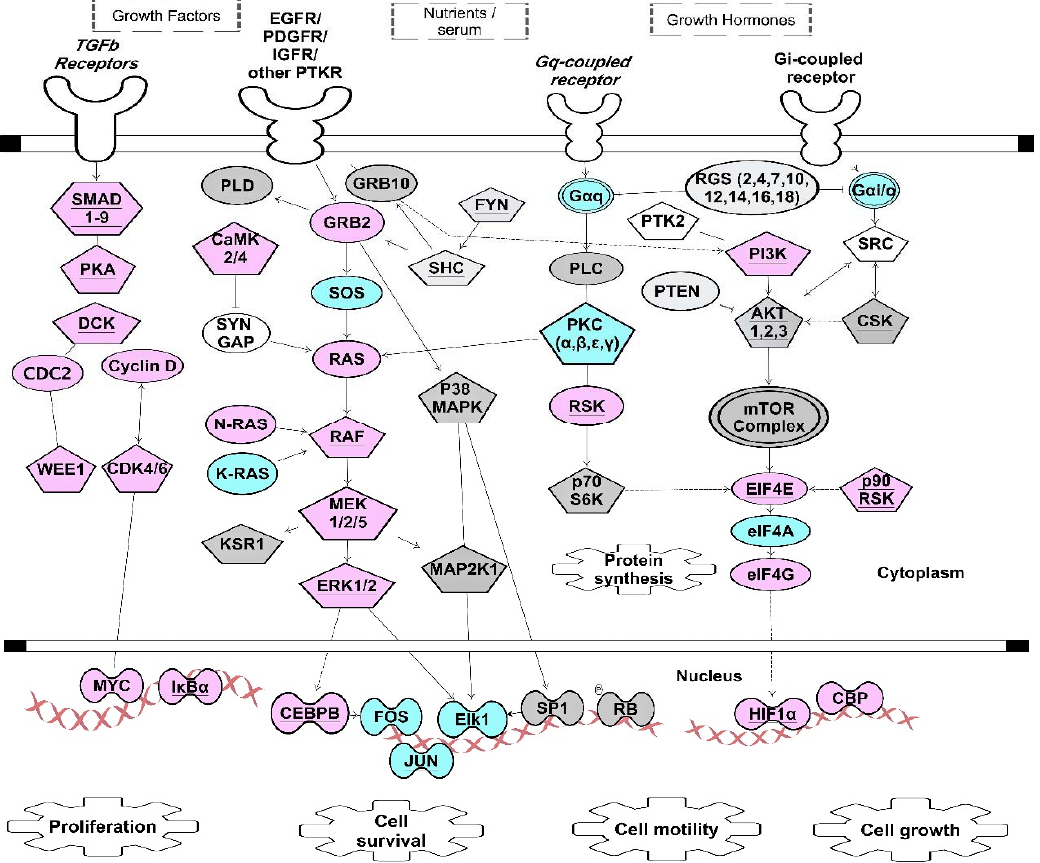
Figure 3. ARE ‐ and GRE ‐ signaling pathways stimulated through growth factors and growth hormones. This figure depicts simplified kinase signaling pathway downstream of growth factor and G protein ‐ coupled receptors that are targets for CELF1, ZFP36 and ELAVL1 [31,61,104]. Proper expressions of these transcripts cooperatively contribute to the overall cellular signaling outcomes such as cell proliferation, cell survival, cell growth and cell motility. Pentagon ‐ shape nodes represent kinase transcripts. Transcripts marked with underlined text were identified as CELF1 targets in resting T cells [61]. Transcripts in blue are targets of both CELF1 and ELAVL1 [31,61]. Transcripts in pink are targets of both ELAVL1 and ZFP36 [31,104]. Transcripts in grey are targets of ELAVL1 but not CELF1 or ZFP36 [31]. Underlined pink nodes represent transcripts that can be targets of all three proteins. Arrows indicate direct interactions and/or activations. Blunt ‐ ended lines indicate inhibitory effects. This network diagram was built using Ingenuity Pathway Assistant Software.